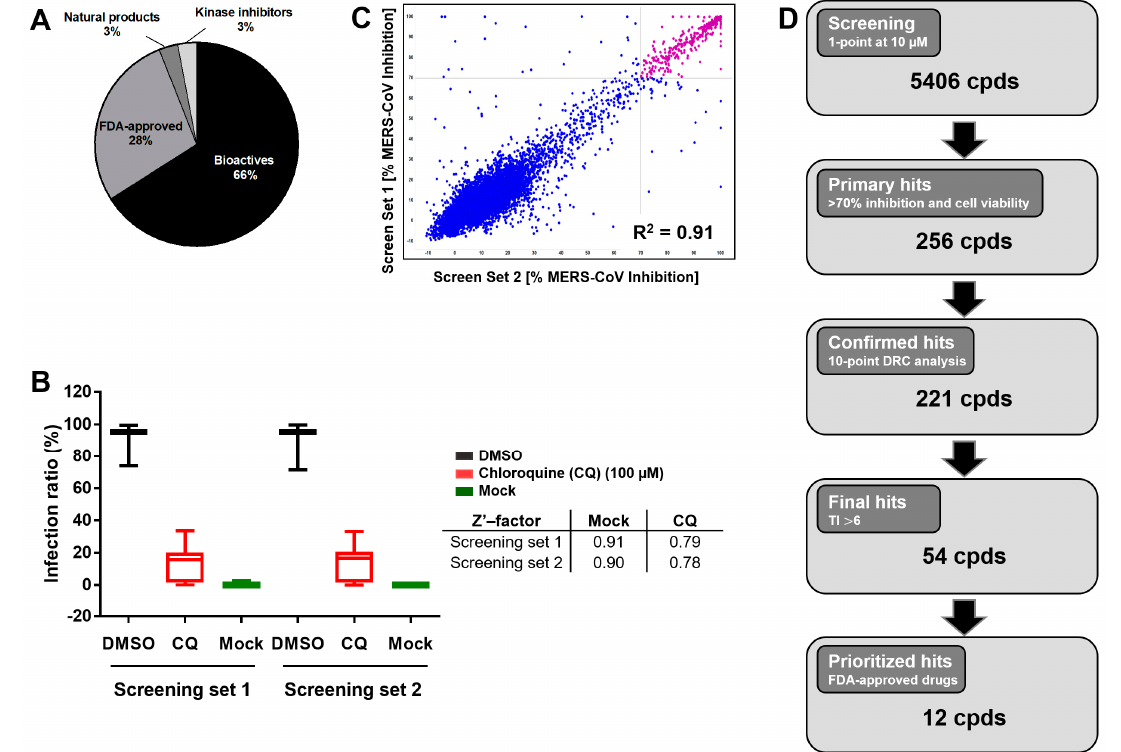
Figure 1. Overview of the library composition and triage of hits. ( A ) Our small-molecule compound library primarily comprised bioactives and FDA-approved drugs, with a small proportion of natural products and kinase inhibitors. ( B ) High-content screening (HCS) of 5406 compounds (cpds) in two batches in duplicate, and calculation of Z’-factors between high (MERS-CoV infection, black) and low (mock, green) values. Chloroquine (CQ). ( C ) Correlation between duplicate screens. The scatter plot shows Middle East respiratory syndrome coronavirus (MERS-CoV) inhibition ratios overlaid with cell viability ratios. Compounds with MERS-CoV inhibition >70% and cell viability >70% were regarded as primary hits. ( D ) Flowchart of HCS hit selection and confirmation of final hit selection.